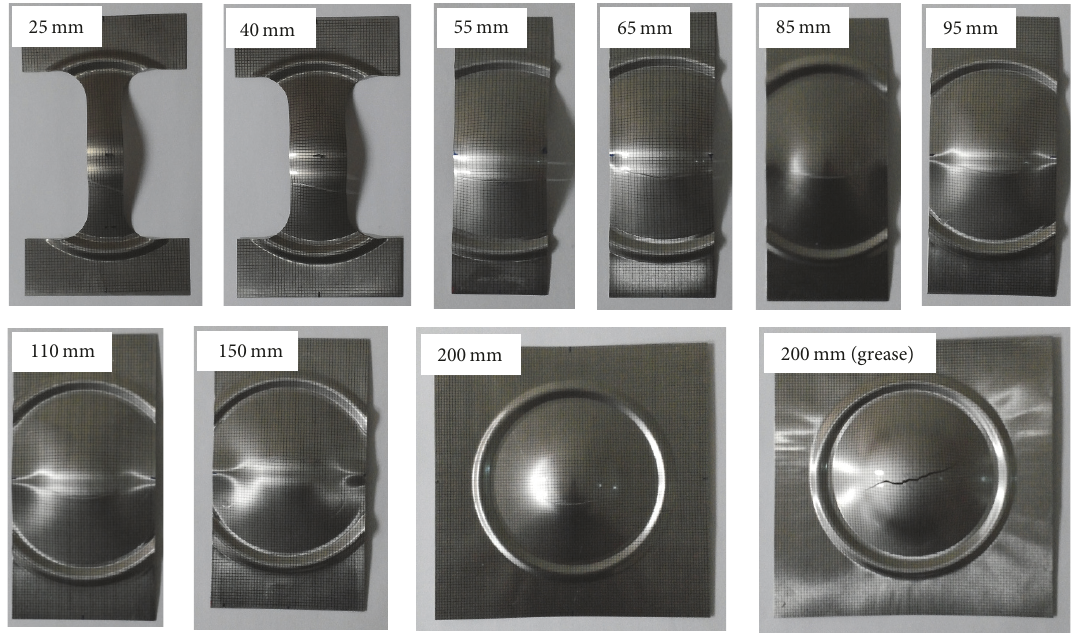
Figure 4: Workpieces after dome stretching test.